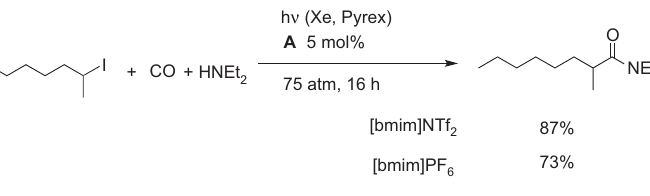
Scheme 4 Mizoroki-Heck reaction with catalyst/solvent